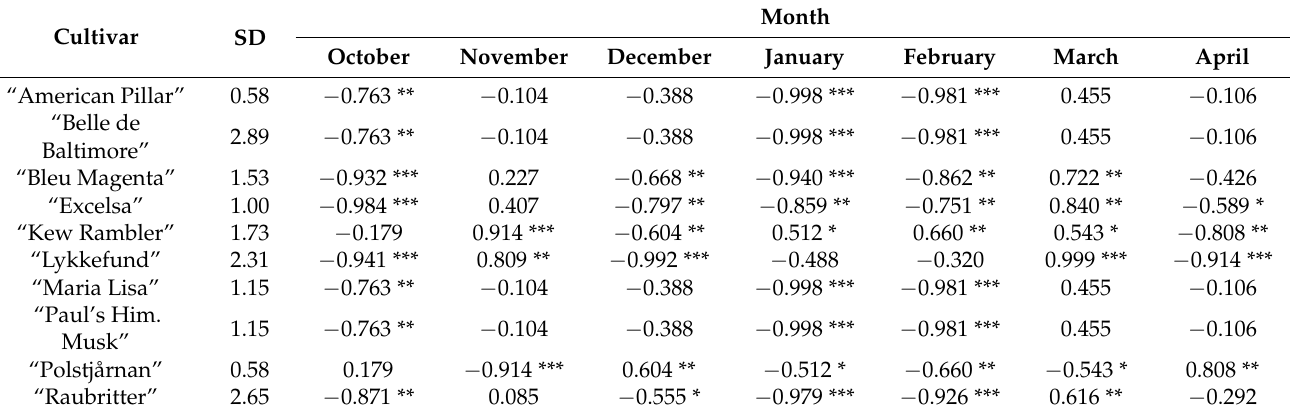
Table 2. Correlations between average monthly air temperature (2005/2006, 2009/2010, and 2015/2016) and frost damage of rambler roses.